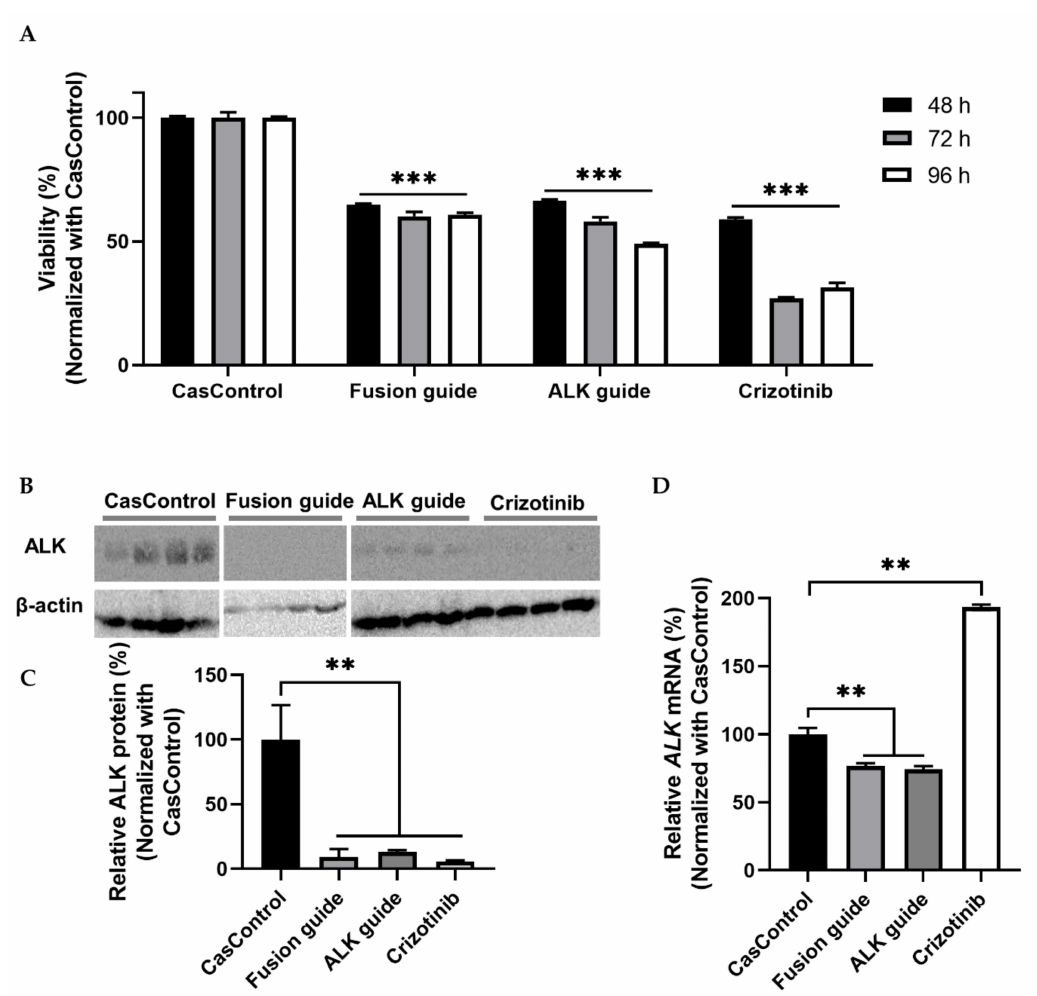
Figure 6. Cell viability and EML4-ALK knockdown in H3122 cells. ( A ) Cell viability (determined by MTT assay) after knockdown in H3122 cells at 48, 72, and 96 h after transfection. CasControl, nontargeting guide; Fusion guide, EML4-ALK target guide in the fusion point; ALK guide, EML4-ALK targetguideinthetyrosinekinase(TK)domain; Crizotinib, positivecontroldrug. ( B )Western blotting of ALK knockdown. H3122 cells treated with Cas13a and guide RNA or crizotinib for 72 h. CasControl, Cas13a with nontarget guide; Fusion guide and ALK guide, EML4-ALK target guide RNAs; Crizotinib, positive control drug. β -actin was used as a loading control. ( C ) Representative graph of western blot gel image shown in ( B ). ( D ) qRT-PCR results of ALK mRNA knockdown in H3122 cells treated as in B . All data represent mean values ± SEM from three, four, or six individual experiments. qRT-PCR results represent three biological replicates and two technical replicates. Statistical significance was determined by Student’s t -test. *** p < 0.001, ** p <